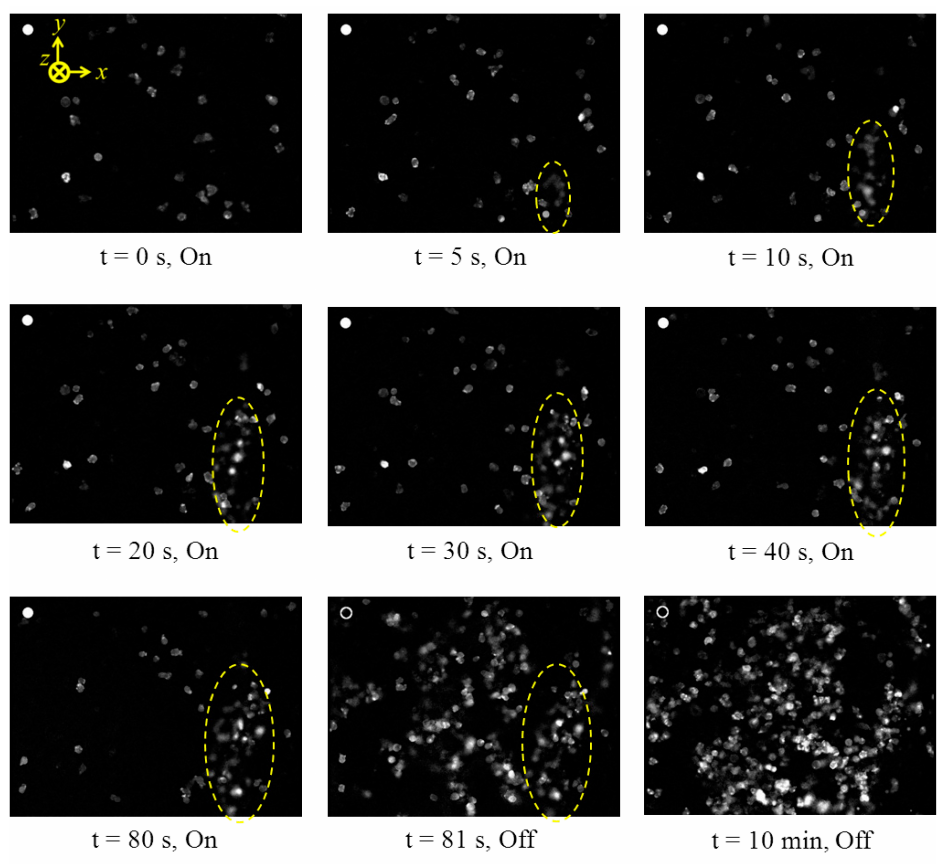
Figure 18. Image sequences of the formation of an agglomeration of cells in the curved ultrasonic resonator field. The circle at the top- left of each image is 10 μm diameter. The filled circle denotes that the transducer is